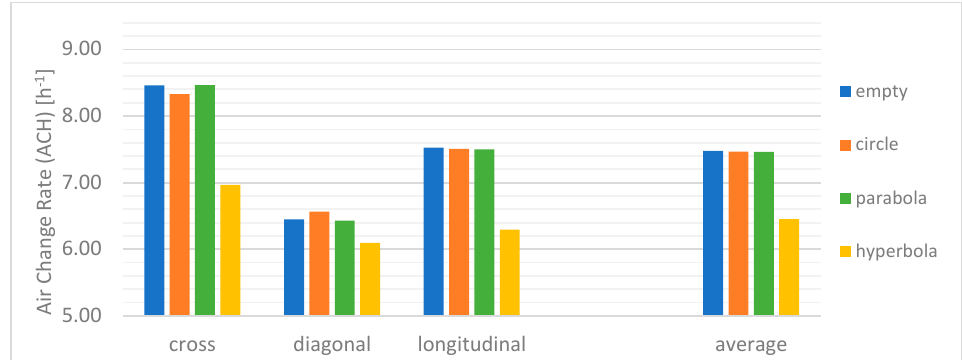
Figure 11. Comparison of the four geometry variations’ ventilation performance in ACH [h − 1 ].